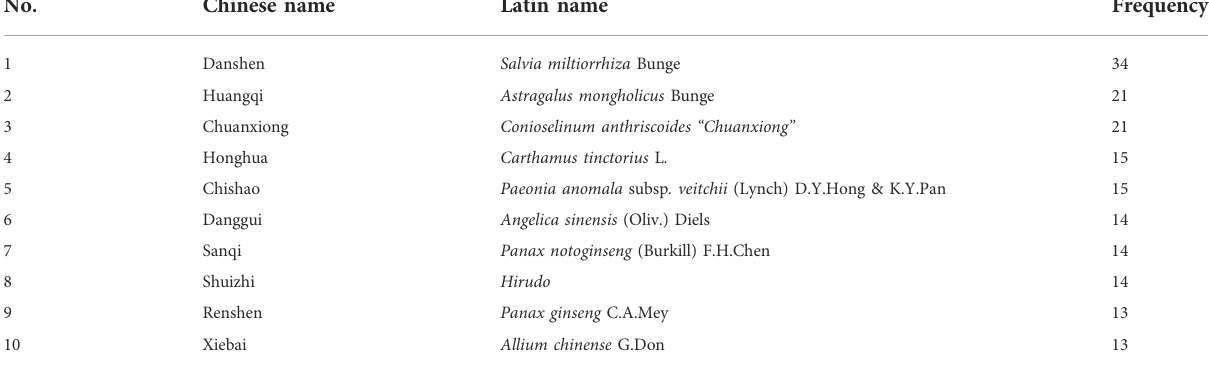
TABLE 3 The top 10 Chinese herbs ranked with relatively high usage frequency.